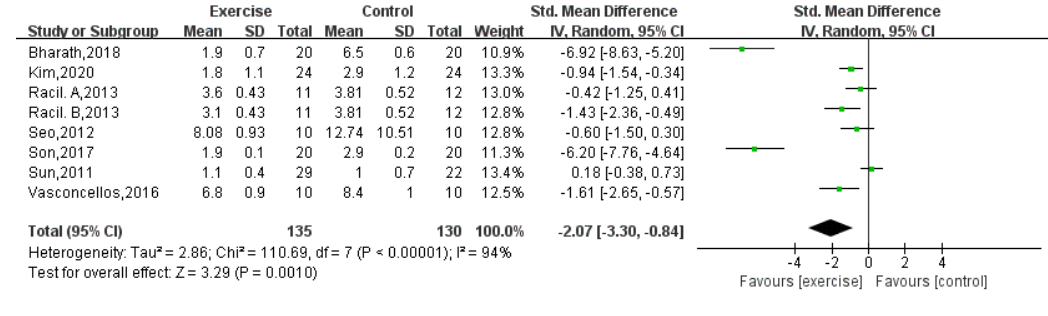
Figure 9. Forest plot of HOMA-IR.